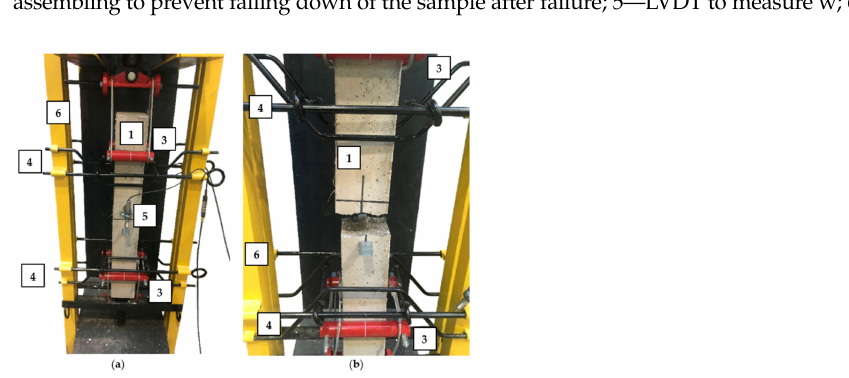
Figure 7. Picture of the sample: ( a ) before the uniaxial tensile test; ( b ) after the uniaxial tensile test: 1—sample; 3—grip; 4—bar assembling to prevent falling down of the sample after failure; 5—LVDT to measure w; 6—rigid